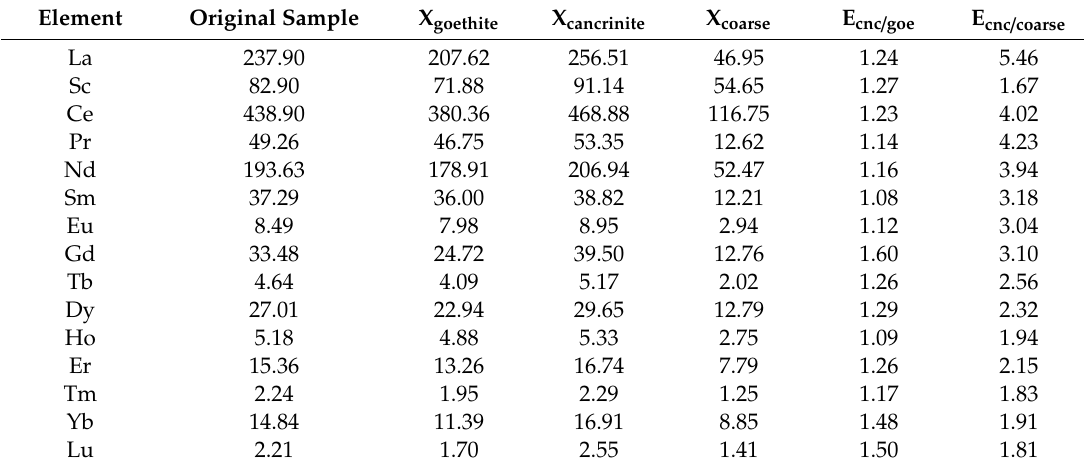
Table 6. Calculated REE concentrations (all in ppm) in pure cancrinite, goethite, and coarse-grained fractions as well as the enrichment factors